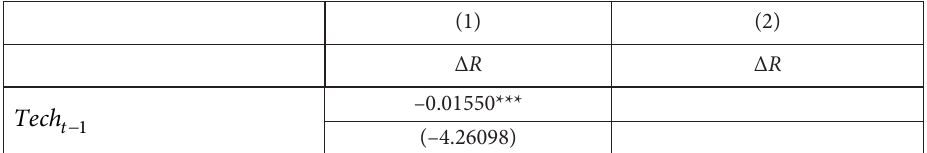
Table 3. The effects of different channels on banks’ market